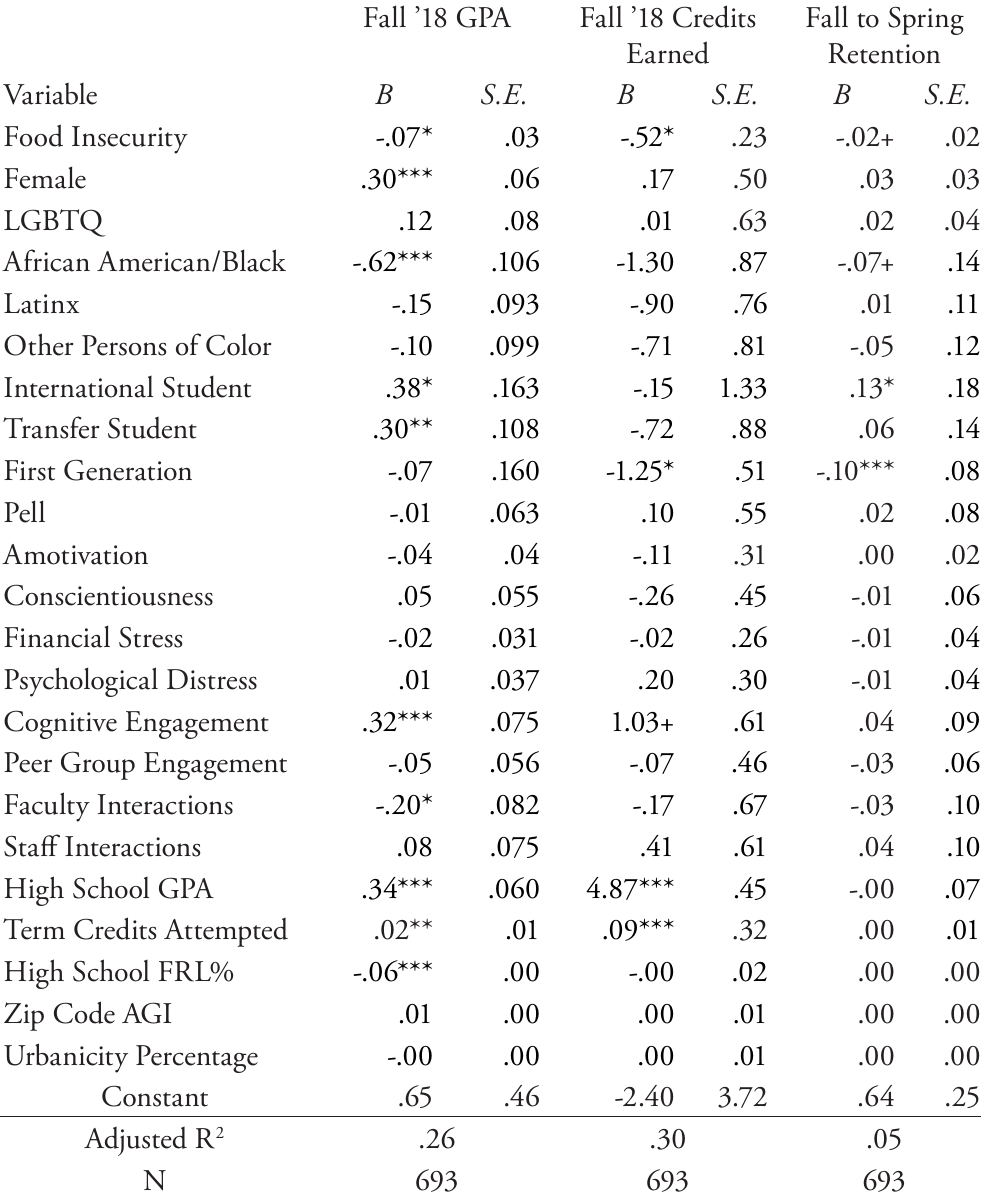
Table 5: Predicting Fall GPA, Credits Earned, and Fall to Spring